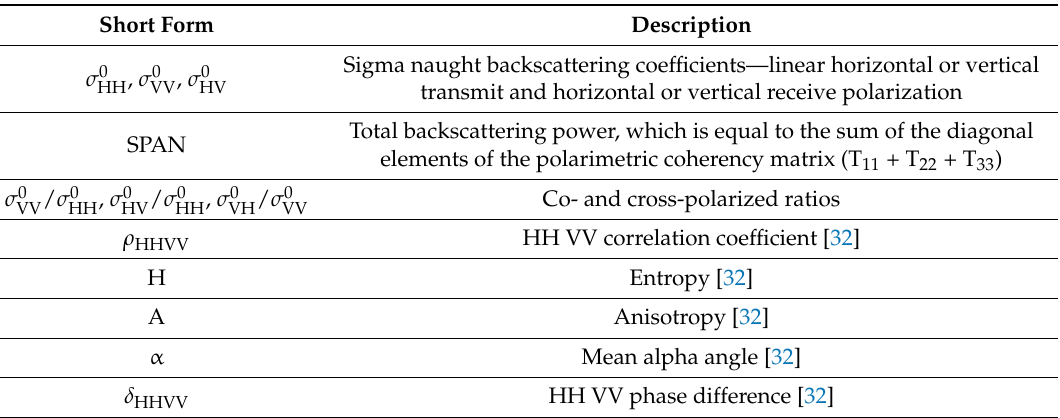
Table 2. Polarimetric parameters used in this